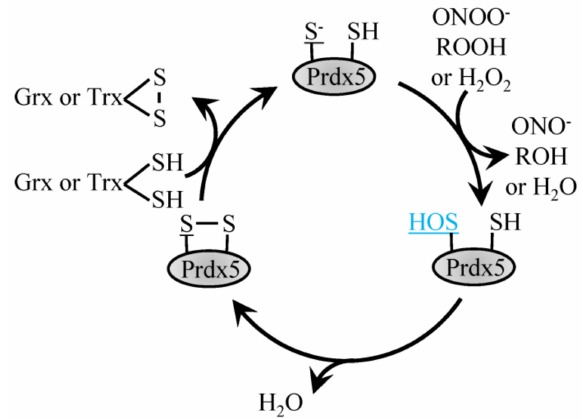
Figure 2. Reduction of H 2 O 2 by atypical Prdx5. H 2 O 2 , ROOH and ONOO - recycling by 2-Cys atypical